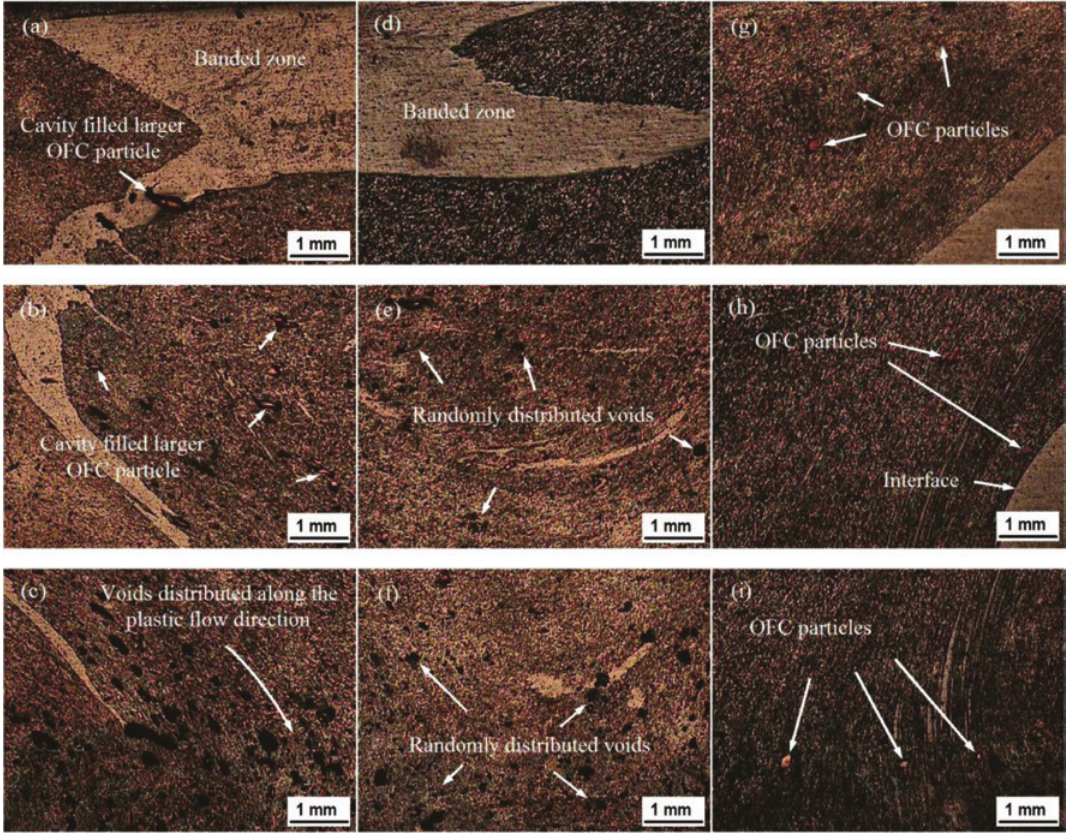
Figure 5: Optical microscope images taken from the cross section of different areas in dissimilar metal butt joints at a rotation speed of 2093 rpm. (a) to (i) Indicates sampling locations as shown in Figure